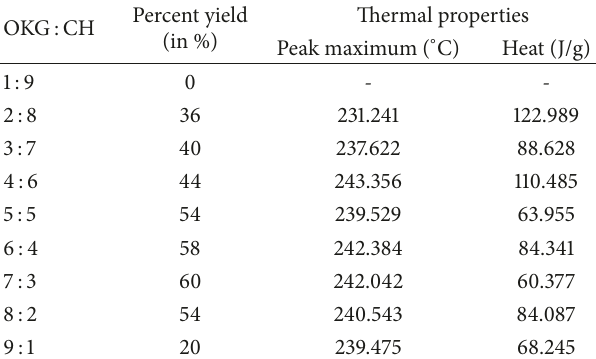
Table1:EffectofdifferentratiosofOKGandCHonpercentageyield and thermal properties of polyelectrolyte complexes.